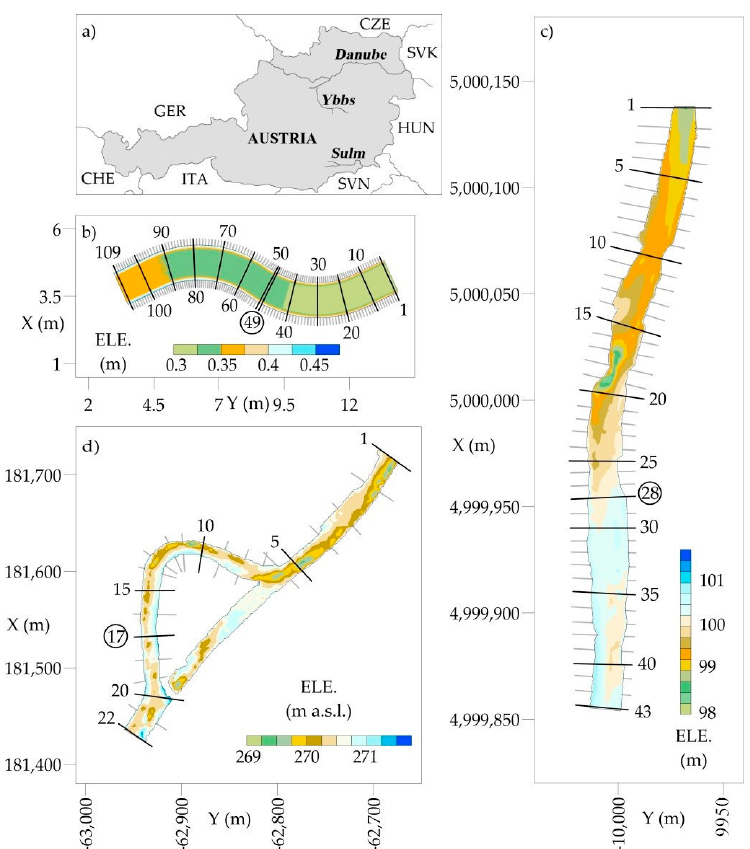
Figure 1. Location of case studies in Austria ( a ); Overview of case studies including cross-sections used for a generalized comparison (grey and black lines) and the indicated cross-section for detailed analysis (encircled): Design of laboratory experiment representing C.1 ( b ), bed elevations of natural river site “Ybbs” representing C.2 ( c ) and bed elevations of natural river site “Sulm” representing C.3 ( d ).